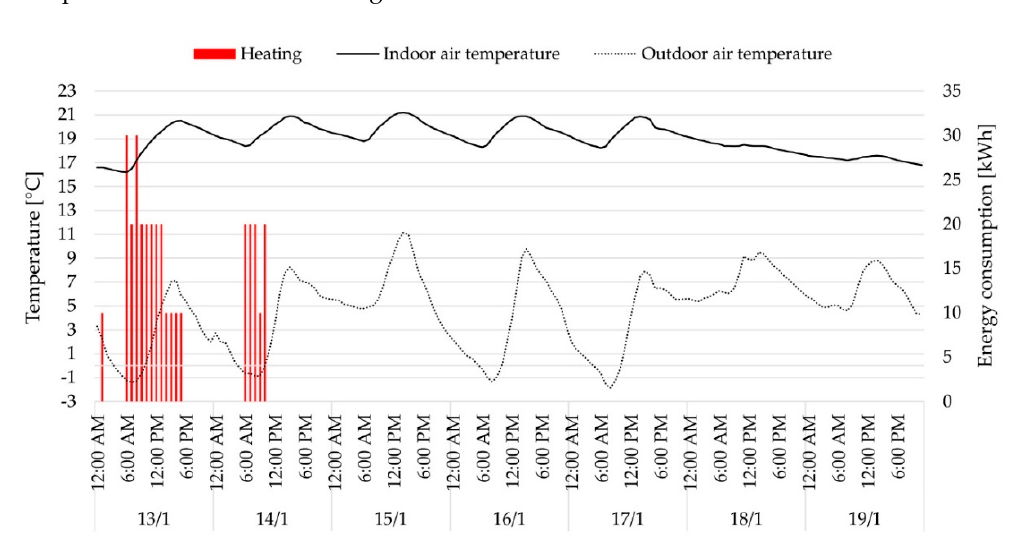
Figure 10. Monitored indoor air temperature vs. outdoor air temperature and heating energy consumption for the coldest week in winter.